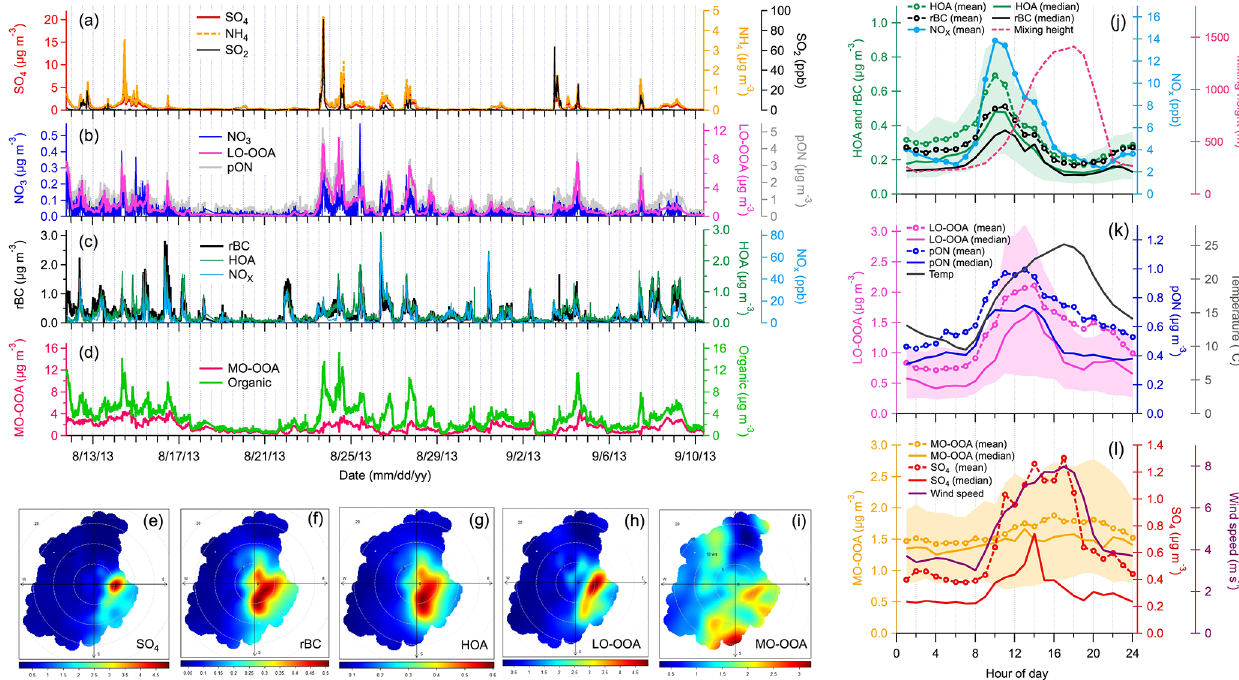
Figure 1. Ground-based observations: time series (a–d) and wind rose plots (e–i) of gas-phase species (SO 2 and NO x ), particle-phase species (organics, SO 4 , NO 3 , NH 4 and rBC) and PMF factors (HOA, LO-OOA and MO-OOA). Correlations ( r 2 values) between all these measurements are presented in Table S1 (Supplement) for the entire sampling period. Other wind rose plots are shown in Fig. S11. (j– l) Diurnal patterns of SP-AMS measurements (rBC and SO 4 ), PMF factors (HOA, LO-OOA and MO-OOA), organo-nitrate (pON), NO x , ambient temperature, local wind speeds and mixing height. Diurnal pattern of pON / total OA ratio is shown in Fig. S14. While mean values could reflect the influences of pollutant plumes on mass loadings, median values could better represent the central tendency of measurements that are less affected by individual plumes. Both mean and median values of SP-AMS measurements and PMF factors are presented. The upper and lower values of shaded regions represented 25th and 75th percentiles of diurnal variations in PMF factors,